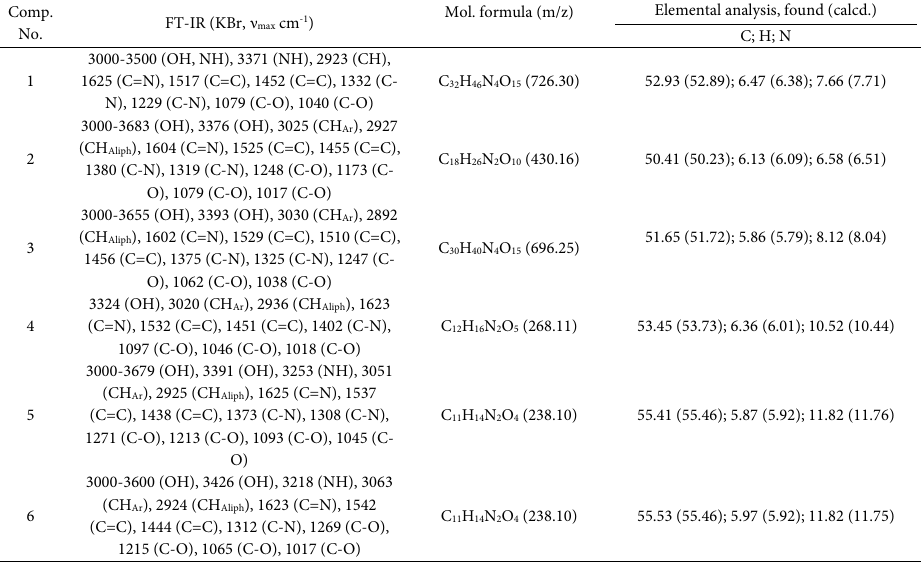
Table 4. Characterization data for compounds (1-6)